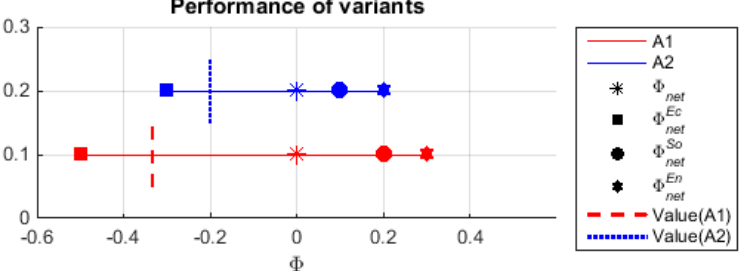
Figure 2. Evaluation of two sample variants in terms of economic, social and environmental criteria, and their global evaluation using the PROSA method.